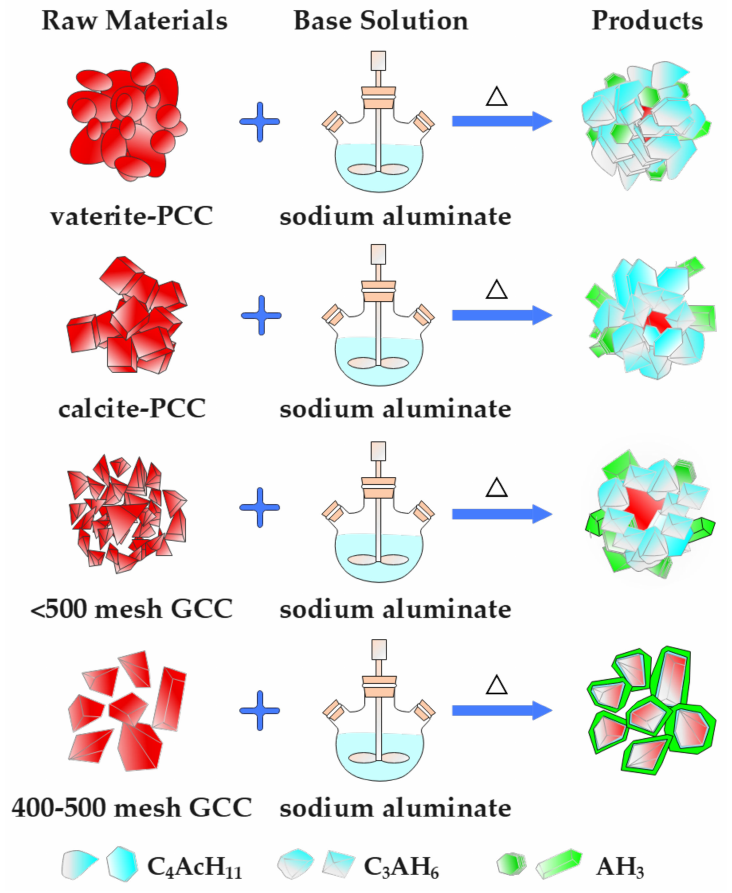
Figure 9. Schematic diagram of reaction